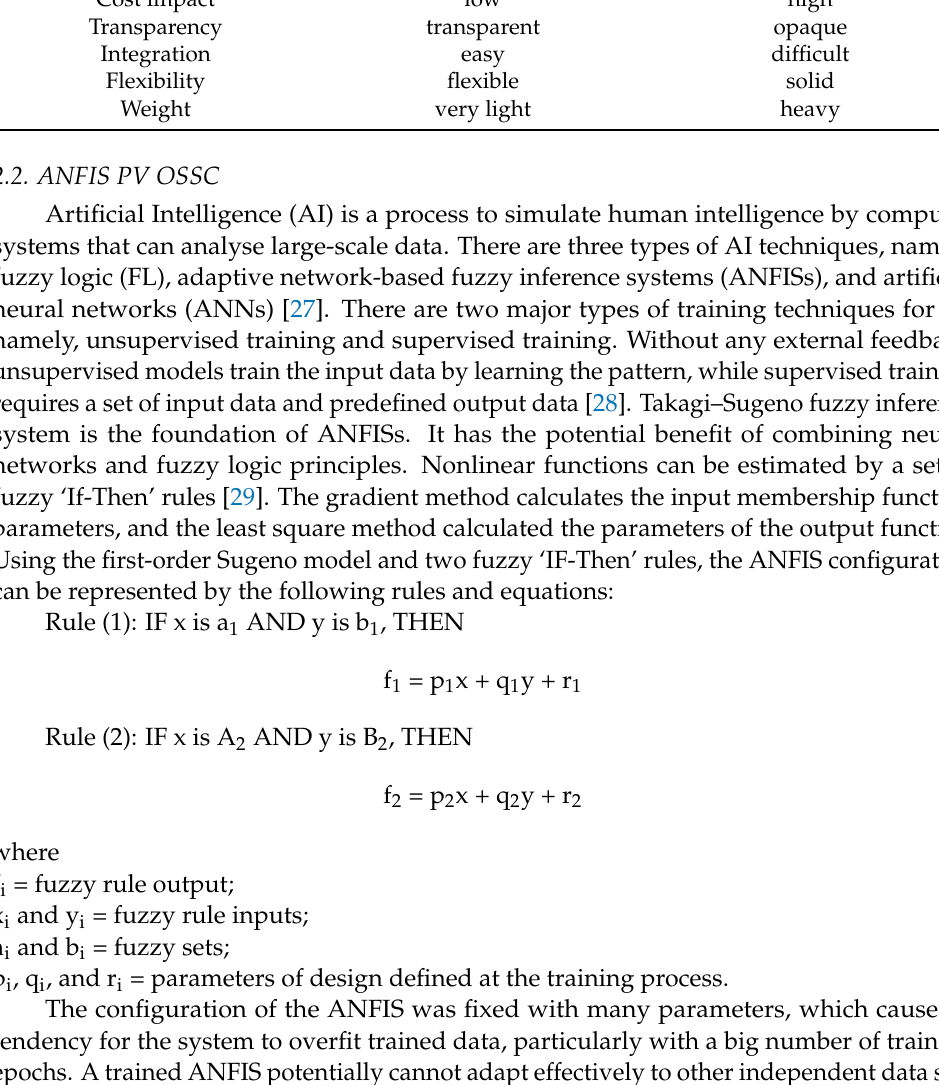
Table 1. Difference between organic and inorganic PV cells. Attributes Organic PV Inorganic PV Life cycle 10,000 h 10 years Efficiency ~10% ~25% Cost impact low high Transparency transparent opaque Integration easy difficult Flexibility flexible solid Weight very light